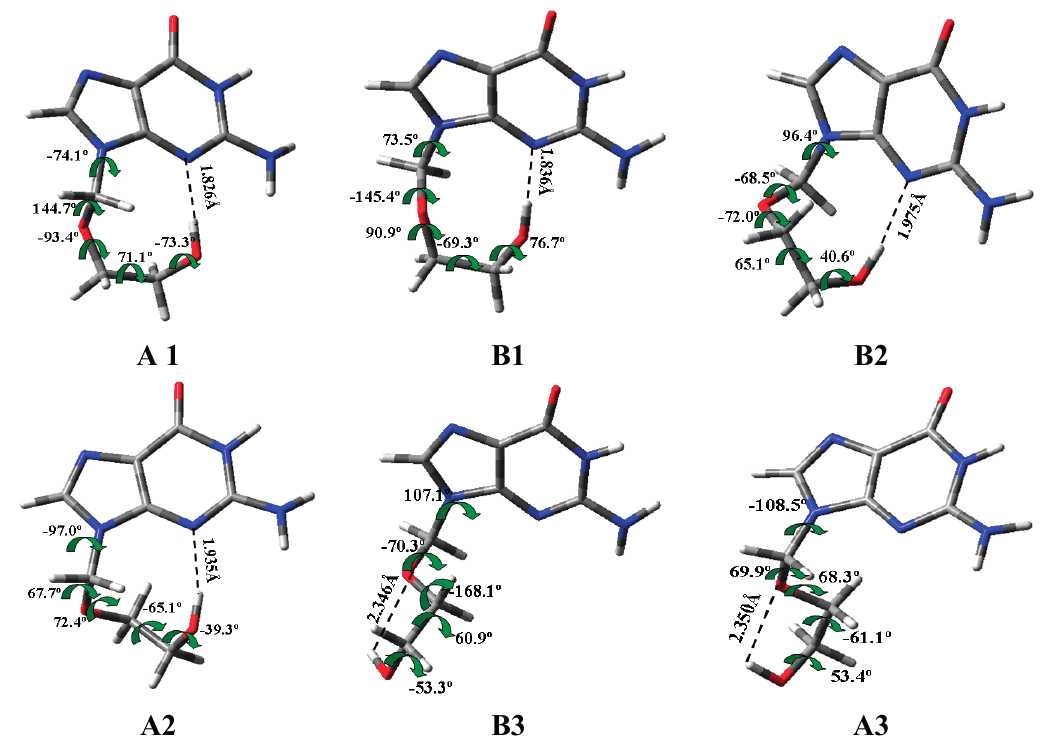
Figure 4. Geometry of the six most optimum conformers selected for each rotation angle φ determined in A1 conformer of N1 tautomer of acyclovir at B3LYP/6-31G(d,p) level. 1 The values of the strongest intramolecular H-bonds are also included.